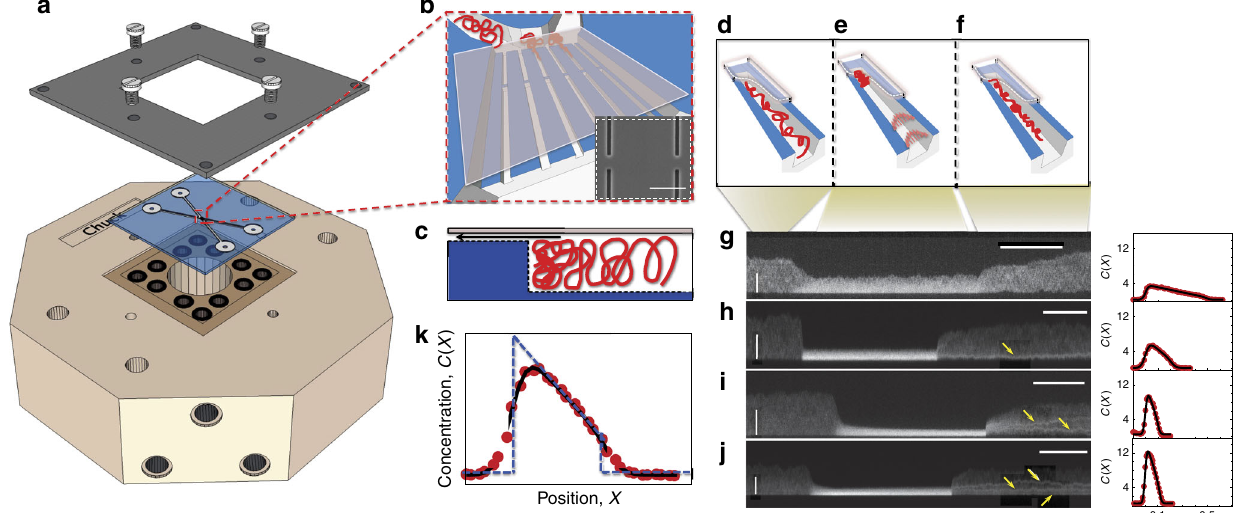
Fig. 1 Device concept and experimental set-up. a The nano fl uidic device is mounted on a chuck containing inputs for application of pneumatic pressure to transport DNA molecules in micro and nanochannels and enable hydrodynamic compression against slit-barriers. b A magni fi ed view of the chip center. The device is composed of two 1- μ m deep loading channels spanned by a nanochannel array with blunt-ended barriers in the channel centers. A 30-nm deep slit, etched over the array, allows for solvent to escape while preventing the passage of large DNA molecules. Inset: an SEM image of the nanochannels with barrier (the scale bar is 3- μ m). c A magni fi ed cross-sectional view of a nanochannel at the device center showing the slit-barrier. The black arrow depicts the fl ow direction through the slit. d – f A 3D cartoon showing the process of knot-formation detailing d DNA con fi nement, e compression against the barrier via hydrodynamic fl ow induced by applying a pressure-drop across the nanochannels and f relaxation of a knotted chain. The red arrows in e depict the fl ow velocity pro fi le during compression. g – j Examples of kymographs for knot-formation events with increasing compression degree. Intensity along the nanochannel (vertical axis, scale bar10 μ m) is plotted vs. time (horizontal axis, scale bar 10 s). Each molecule is compressed, held at a minimum extension for a waiting time t w , and then relaxed. Normalized chain concentration pro fi les corresponding to the kymographs are illustrated on the right. g No knot is formed; h one knot is formed; i two knots and j three knots are formed. The yellow arrows depict the knot locations. The second bright spot in h does not maintain its size and unravels in the chain mid-section shortly after pressure release so we do not count it as a knot 20 . k Normalized chain concentration pro fi le C ( X ), averaged over waiting time at compressed state; red circles are experiment; black line is a fi t to a linear ramp concentration pro fi le (Eq. 1) convolved with a Gaussian point-spread function (Supplementary Note 3D). The blue-dashed line shows an estimate of the real, i.e., prior to convolution, concentration pro fi le estimated from the fi